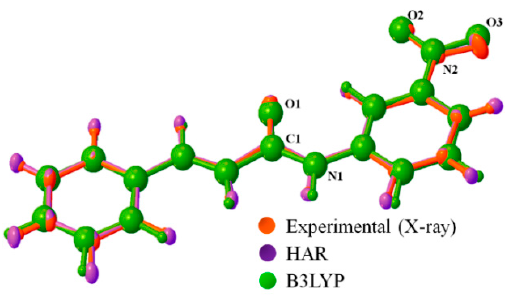
Figure 7. Superimposition of the X-ray structure of Compound 1 (orange) and its HAR (purple), B3LYP (green) optimized counterpart (red).